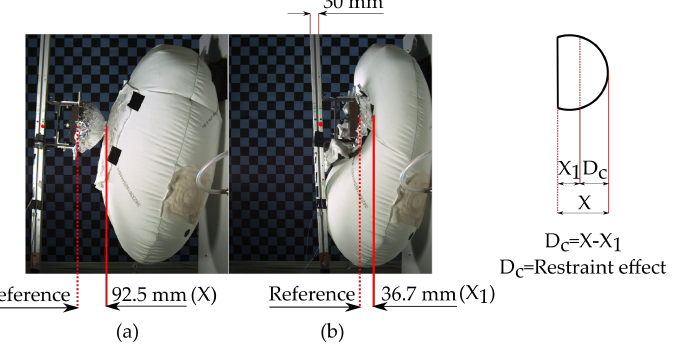
Figure 14. Depth calculation from high-speed video: ( a ) first contact; ( b ) peak